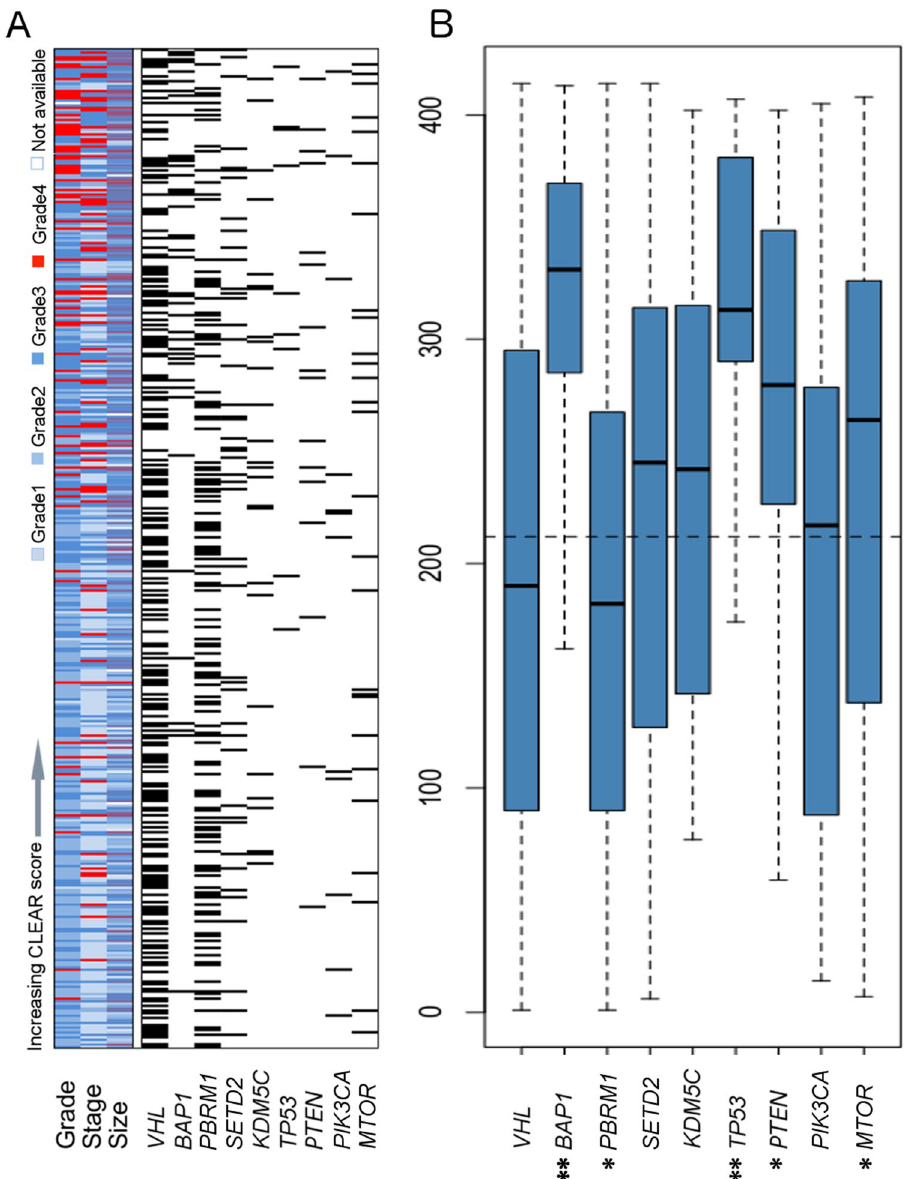
Figure 3. Correlation of CLEAR score and mutation in TCGA cohort. ( A ) Individual correlation between tumor CLEAR score with tumor grade, stage and size distribution as well as mutation status are presented. The correlation of CLEAR score and TCGA grade, stage was investigated by ANOVA (p = 7.769e-09, p = 3.22e-08, respectively); the correlation of CLEAR score and TCGA sample size was estimated by spearman correlation (p = 4.252e-09). ( B ) Boxplots of CLEAR score distribution of samples with relevant gene mutations. The dashed line represents the median CLEAR score of the 414-sample set. Samples with mutated BAP1, TP53, PTEN and MTOR are associated with higher CLEAR scores (Mann–Whitney U test, * p ≤ 0.05, ** p ≤